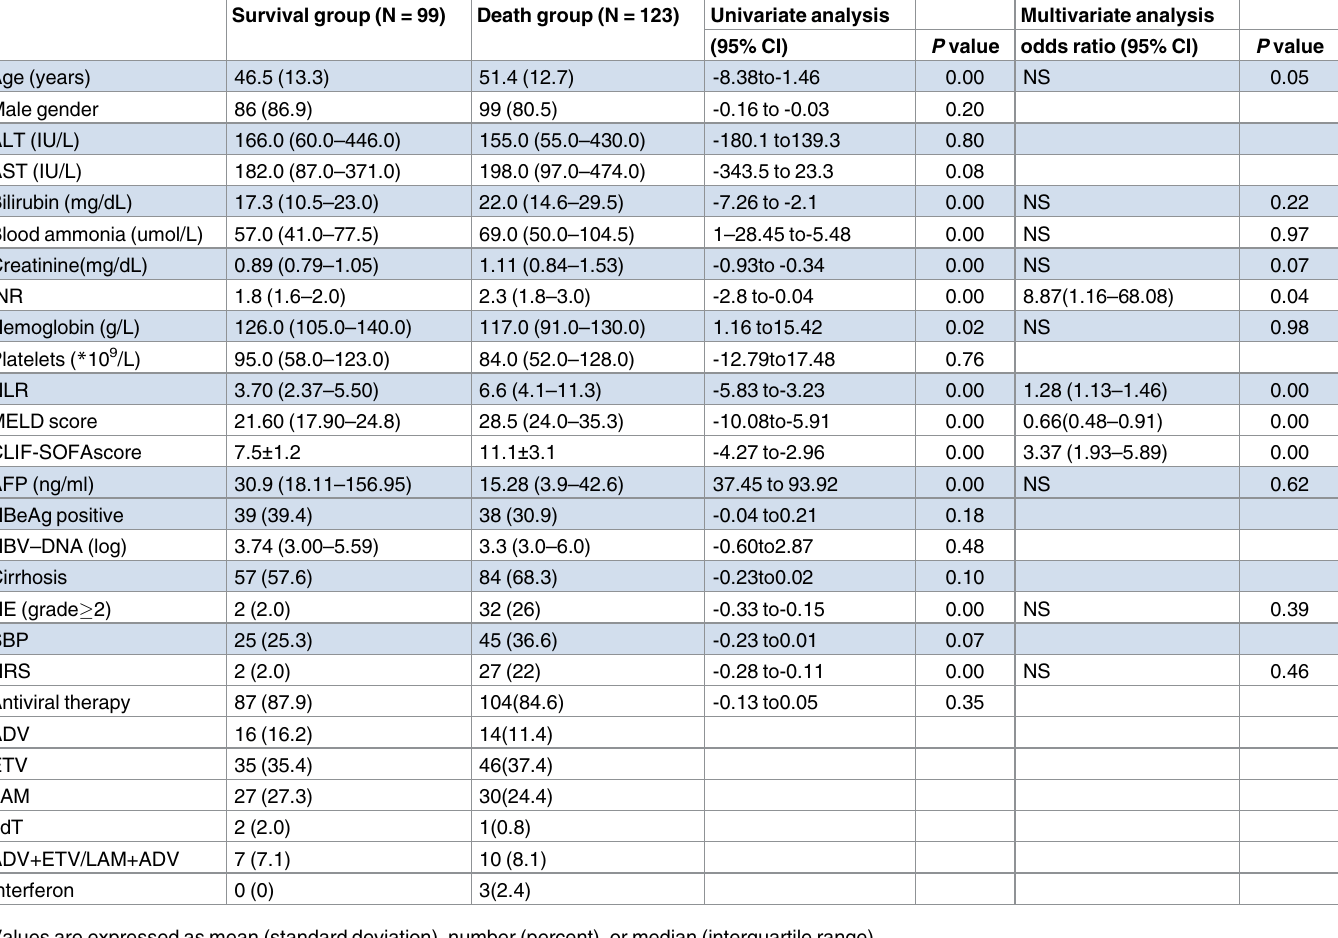
Table 4. Univariate and multivariate analysesof variables affecting 30-day mortality in the SOC